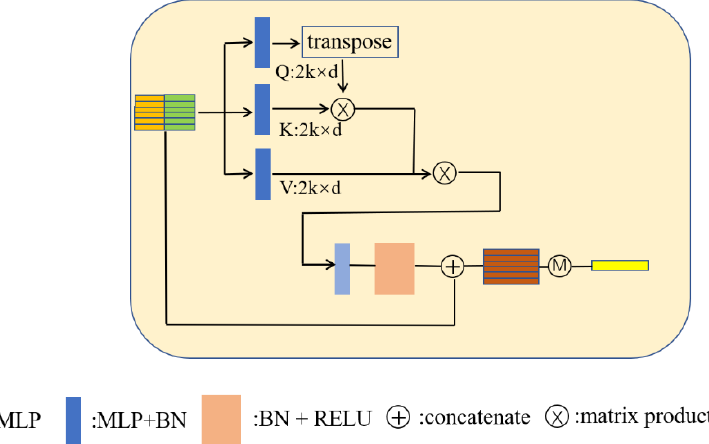
Figure 4. Naïve transformer structure.